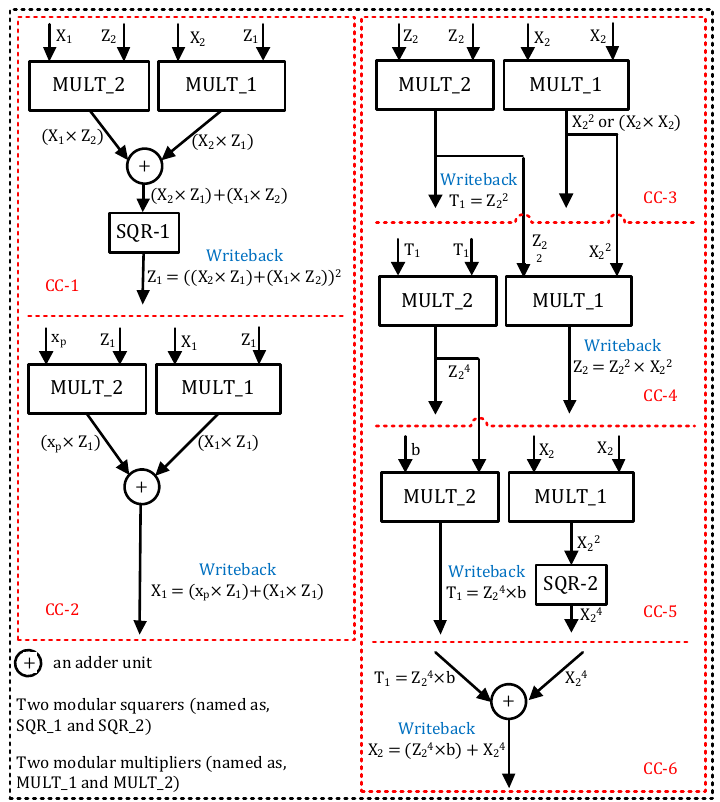
Figure 1. Proposed parallelization scheme for the computation of point addition (PA) and point doubling (PD)